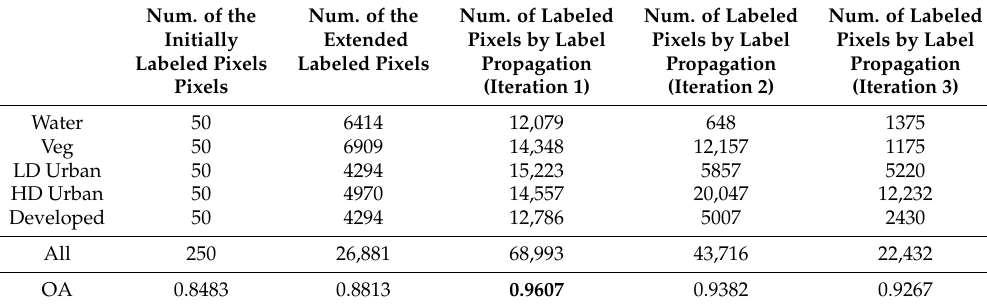
Table 1. The numbers of increased labeled pixels on San Francisco data. Num. of the Num. of the Num. of Labeled Num. of Labeled Num. of Labeled Initially Extended Pixels by Label Pixels by Label Pixels by Label Labeled